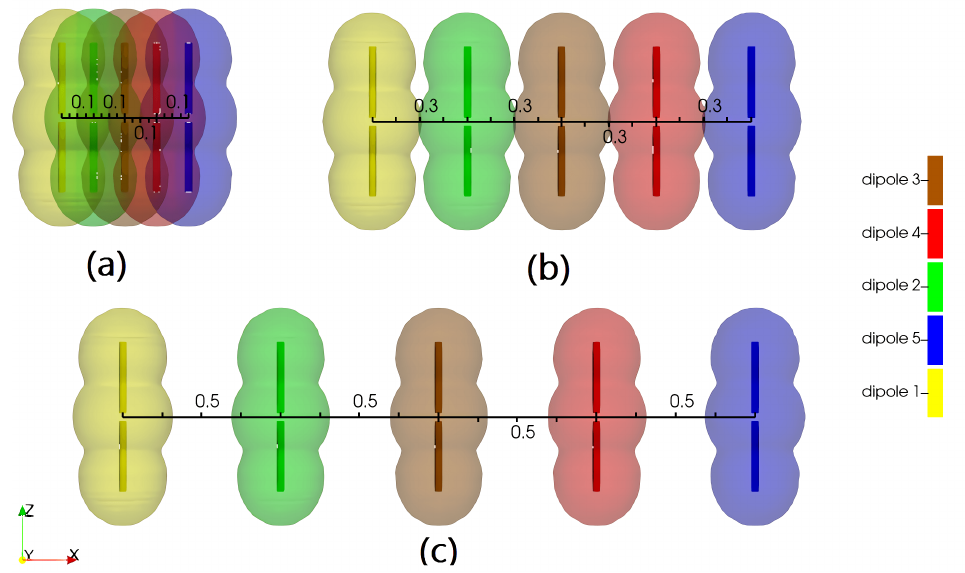
Figure 13. The three investigated linear antenna arrays, each consisting of five λ /2-dipoles. The dis- tance between these array elements is ( a ) 0.1 λ , ( b ) 0.3 λ , and ( c ) 0.5 λ . The reactive NF region, proposed in Figure 12b, is shown around each